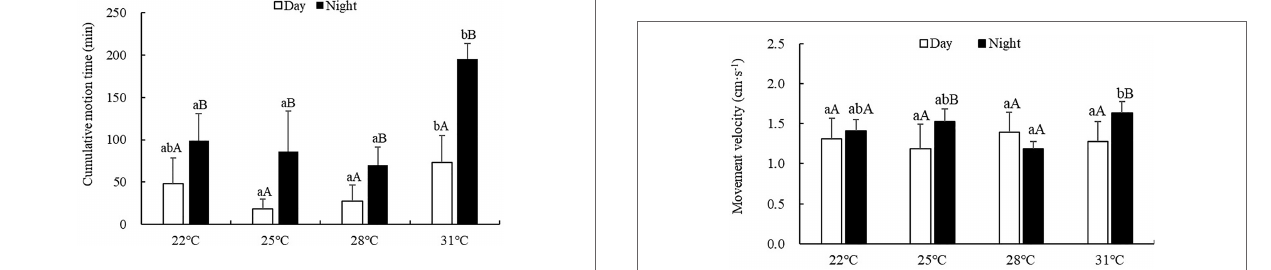
FIGURE 4 | Movement velocity of S. monotuberculatus at four temperature conditions. Marks of lowercase letters indicate that there is a significant difference at different temperatures ( P < 0.05); marks of uppercase letters indicate that there is a significant difference between day and night ( P <